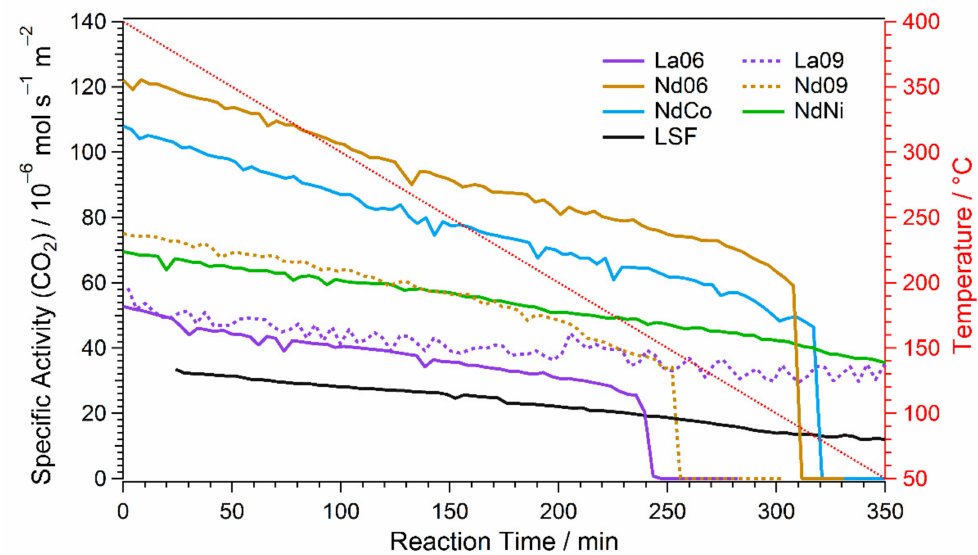
Figure 3. Comparison of CO oxidation results during cooling experiments. The specific activities of the respective perovskites are shown. LSF was added as reference (full black line); the temperature progression during the catalytic test is displayed on the second y-axis. To perform the catalytic tests, a 2:1 mixture of CO and O 2 was used for stoichiometric reasons (4 mL min − 1 and 2 mL min − 1 , respectively). The temperature was decreased from 400 to 50 ◦ C at a rate of − 1 ◦ C min − 1 . The highest activities right before extinction were found for the B-site undoped sample Nd06 and the Co-doped perovskite NdCo (similar to the heating experiments). While LSF exhibits the lowest activities over the whole tested temperature range, it does not show extinction above 50 ◦ C. The same is true for La09 and